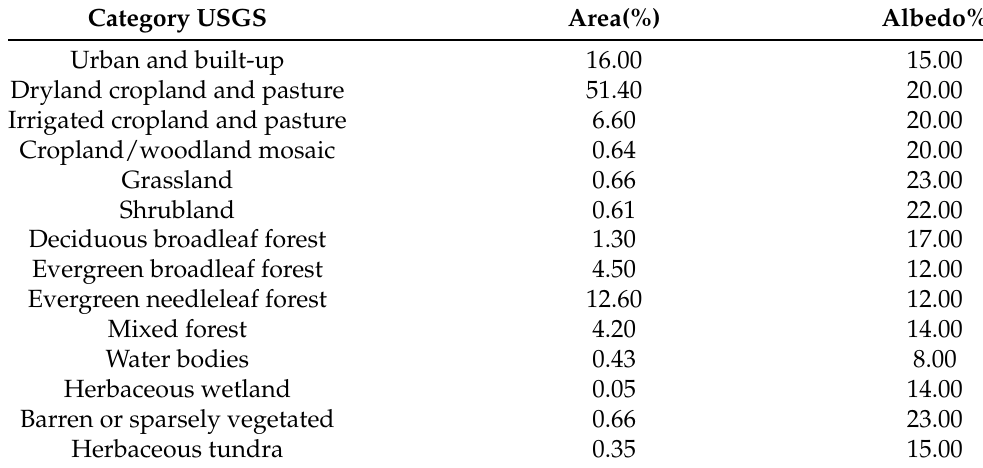
Table 1. Percent area of USGS categories from INEGI’s Serie-VI database and their albedo for winter season taken from